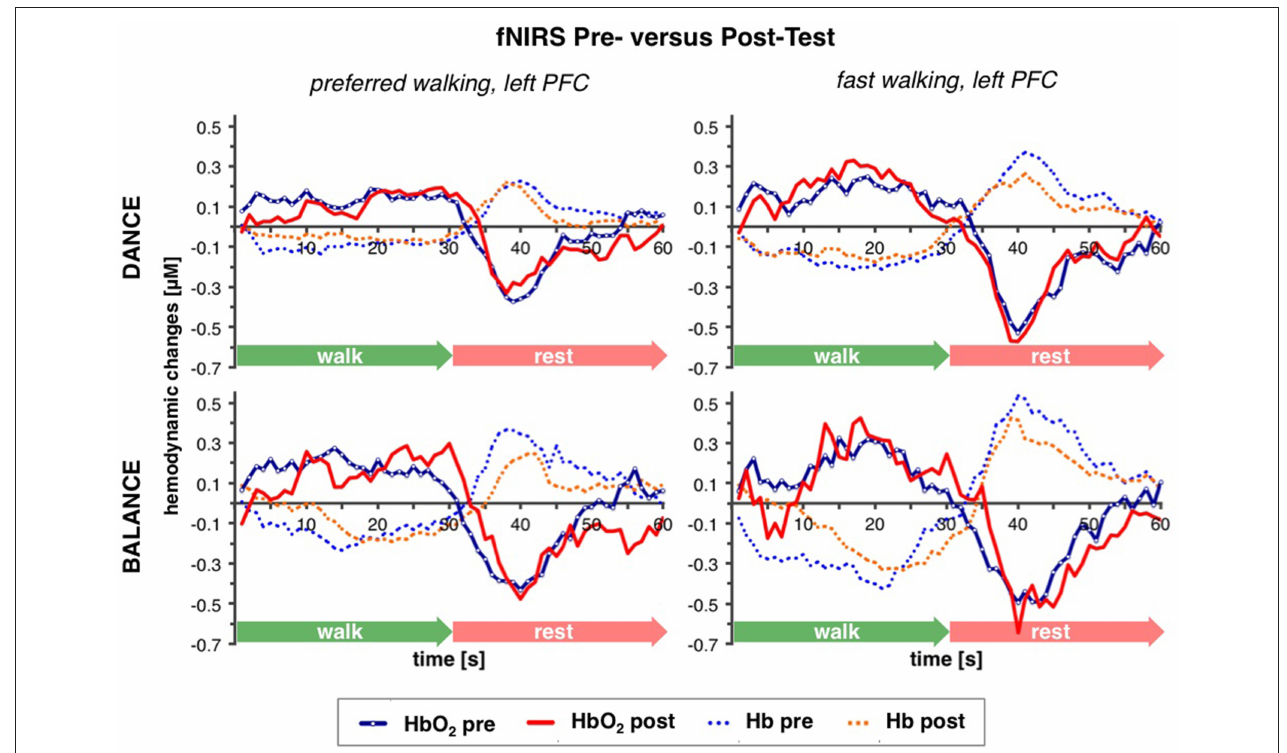
FIGURE 4 | Comparison of pre- vs. post-test PFC activity. Graphs represent time-triggered group averages. Identical line color and style in Figures 4 – 6 represent the same data. Within the first 7 s of walking (t1–7) HbO 2 concentration was significantly reduced at post-test at preferred walking speed (graphs on the left side), whereas a trend for a reduced activity was evident at fast walking speed in the same timeframe (graphs on the right side). At the end of fast walking (t26–34, graphs on the right side) a significant time × intervention interaction reflected reduced HbO 2 concentration in DANCE and increased HbO 2 in BALANCE. DANCE, video game dance training; BALANCE, balance and stretching training, PFC, prefrontal cortex.